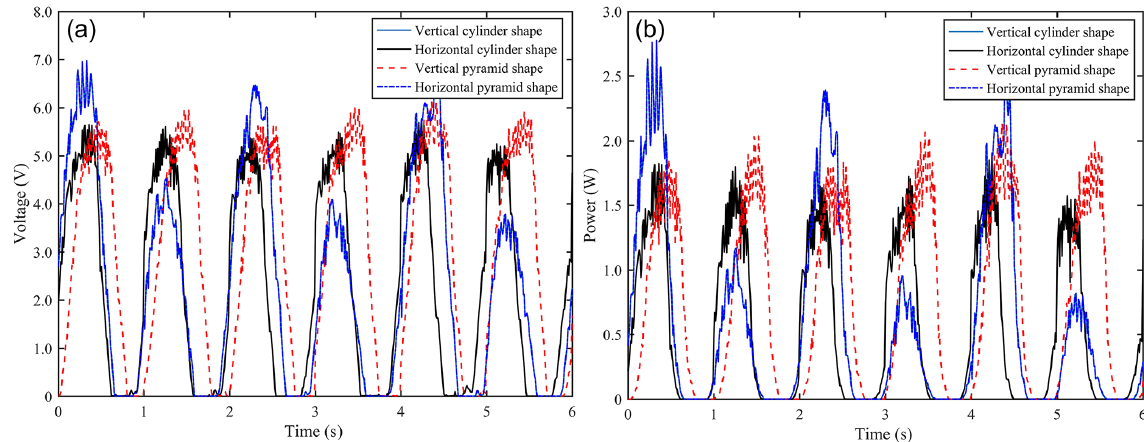
Figure 9. Energy efficiency characteristic curves of the cylindrical and prismatic floating bodies. (a) Voltage curve. (b) Power